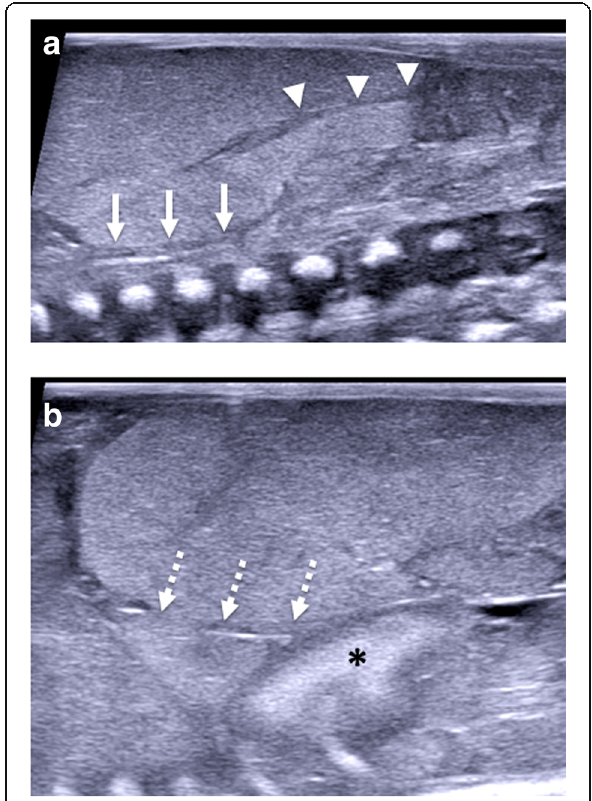
Fig. 13 Sagittal postmortem ultrasound images of the upper abdomen in a 19-week gestational-aged foetus, obtained 8days after death. Images through the abdominal aorta (solid arrows) ( a ) and ductus venosus (arrow heads) are both collapsed. The imaging through the inferior vena cava (dotted arrows) ( b ) show similar appearances. Another finding of note is the echogenic, prominent appearing right adrenal gland (asterisk). This is the usual expected appearance of the adrenal gland on perinatal postmortem ultrasound examinations